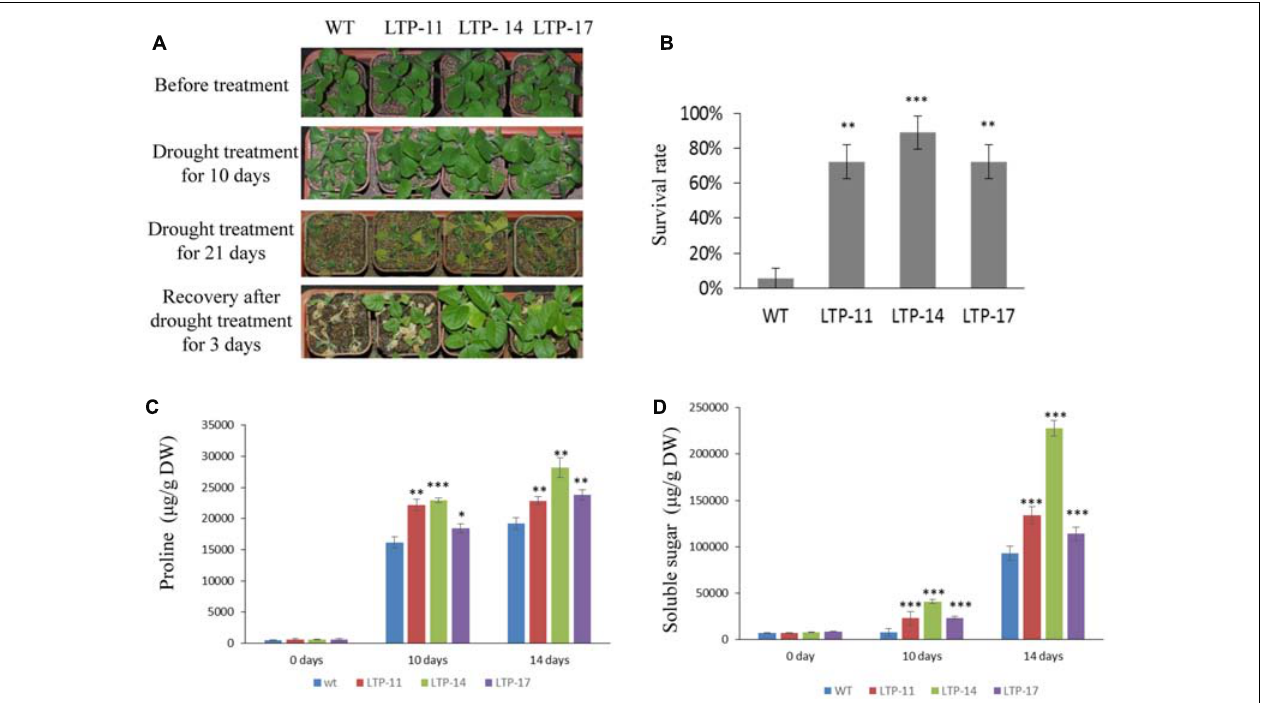
FIGURE 5 | Drought resistance analysis of T1 transgenic and WT tobacco seedlings. Four-week-old seedlings of transgenic lines and WT were not watered for 0, 10, and 21 days, and were then re-watered (A) ; the survival rates of transgenic and WT seedlings after re-watering (B) ; the proline content (C) , and soluble sugar content (D) were analyzed in transgenic and WT plants after exposure to drought for 10 and 14 days, respectively. Six seedlings of each transgenic line and WT were planted in each small basin for the drought treatment and corresponding analysis; 18 plants were used in each experiment. ∗ , ∗∗ , and ∗∗∗ indicate statistically significant differences at P < 0.05, P < 0.01, and P < 0.001 (Student’s t -test), respectively.